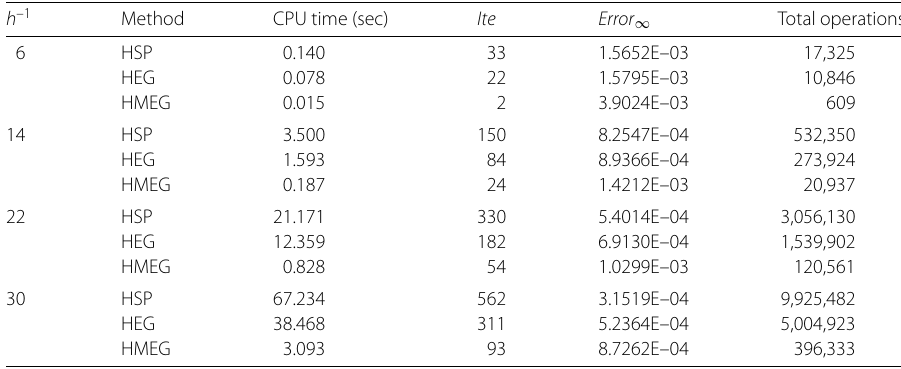
Table 2 The numerical results of the HSP, HEG and HMEG methods at α = 0.1 for Example 5.1